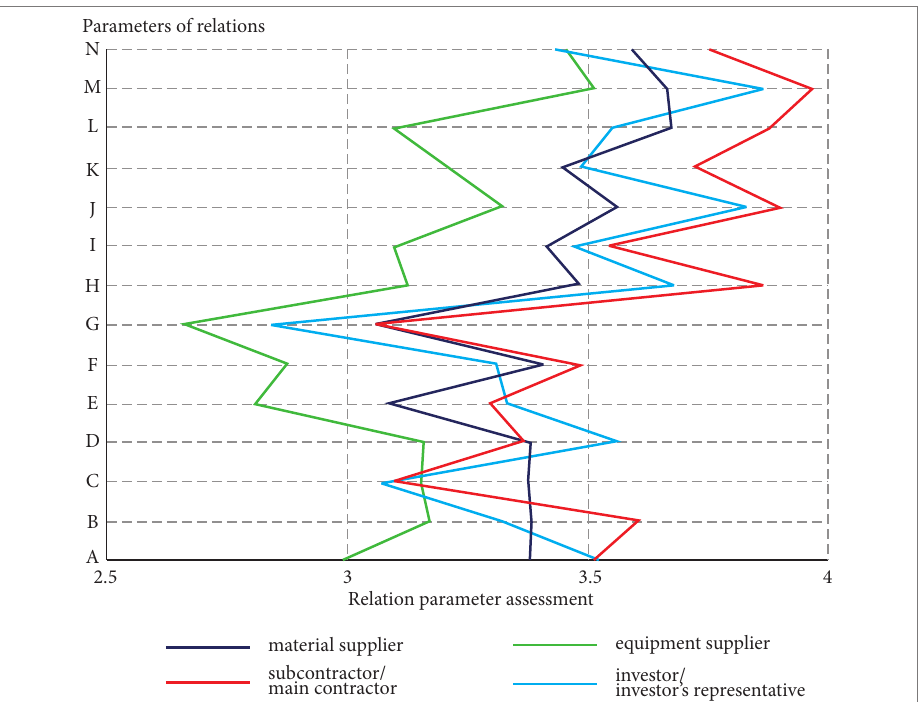
Fig. 2. The assessment profiles of the parameters of relations between Polish construction enterprises and four